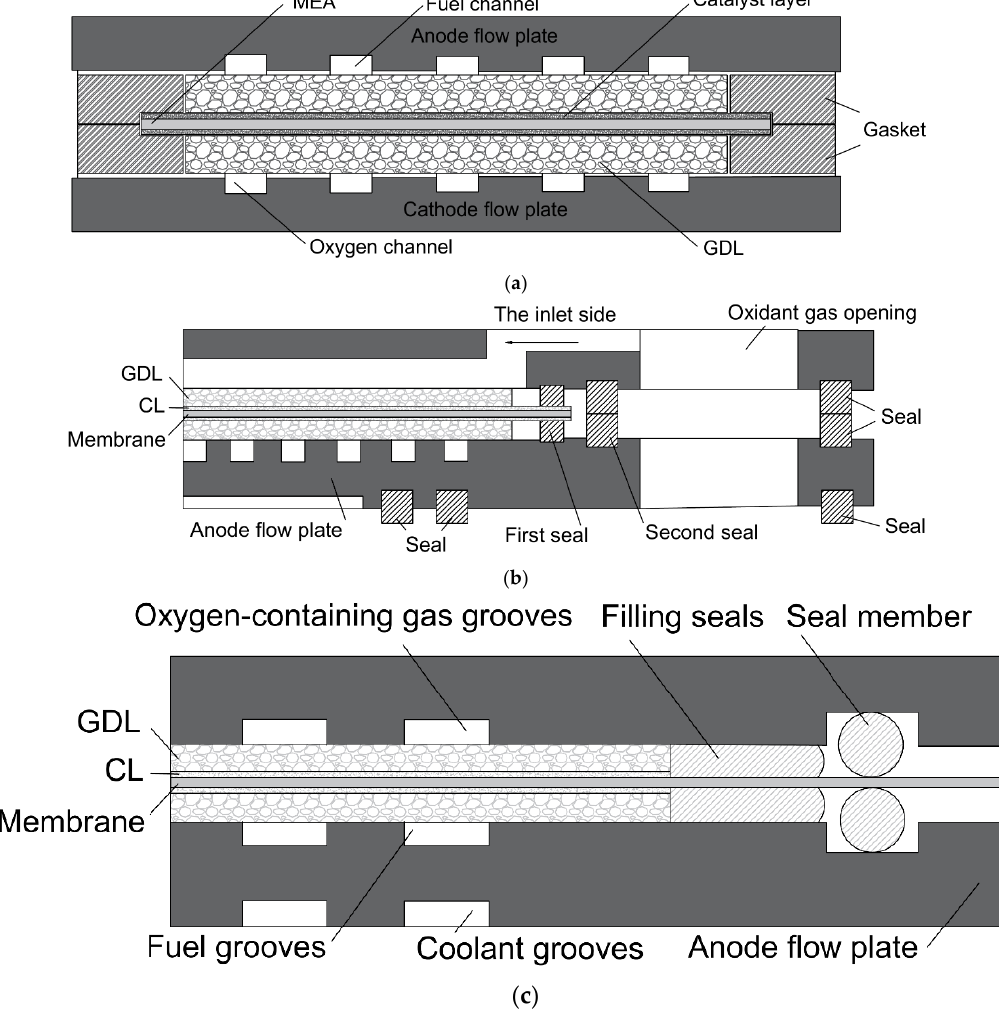
Figure 12. PEM direct-sealing structure: ( a ) Direct sealing, ( b ) dual-sealing assembly, ( c ) double- sealing assembly.